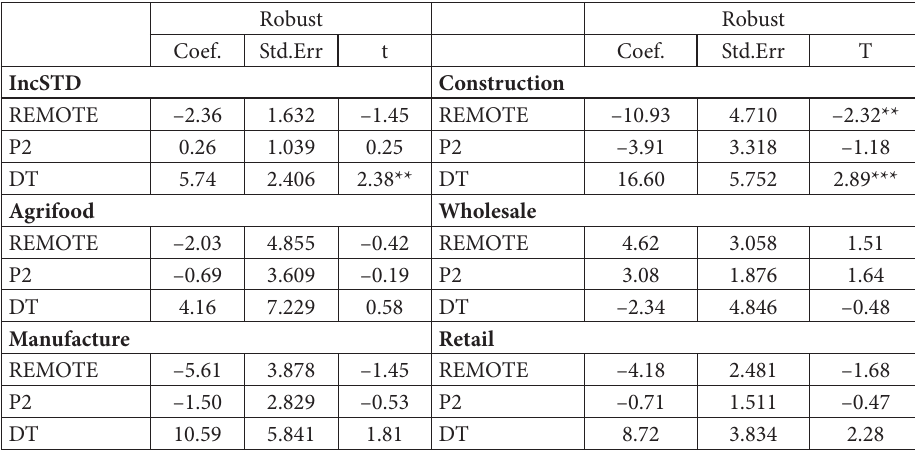
Table 3. DiD test of hypothesis H1 Robust Robust Coef. Std.Err